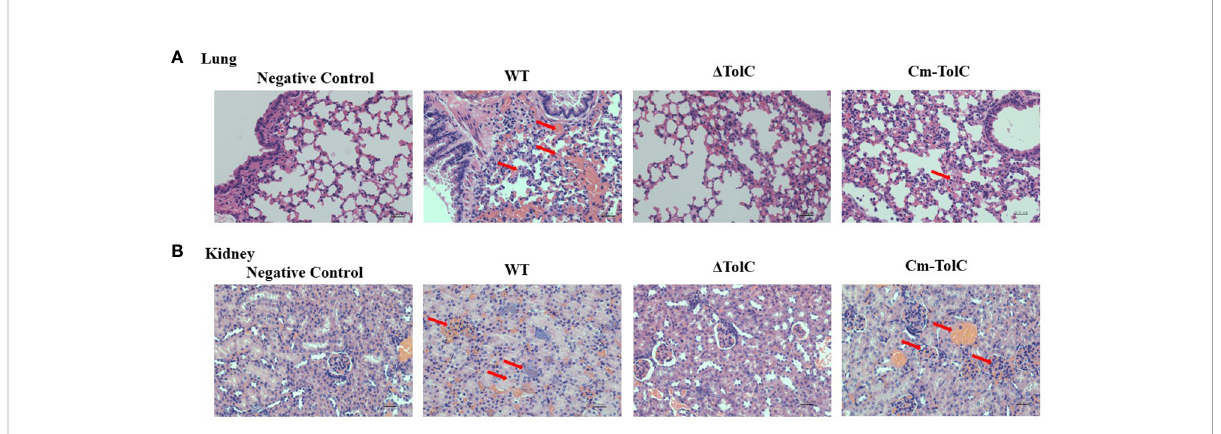
FIGURE 2 Histopathology of lungs and kidney of Kunming mice in different treatment groups. (A) Pathological examination of lungs tissues of the infected mice. (B) Pathological examination of kidney tissues of the infected mice. Arrowheads show the pathological changes. Representative images are shown for each group. Bars, 22.4 m